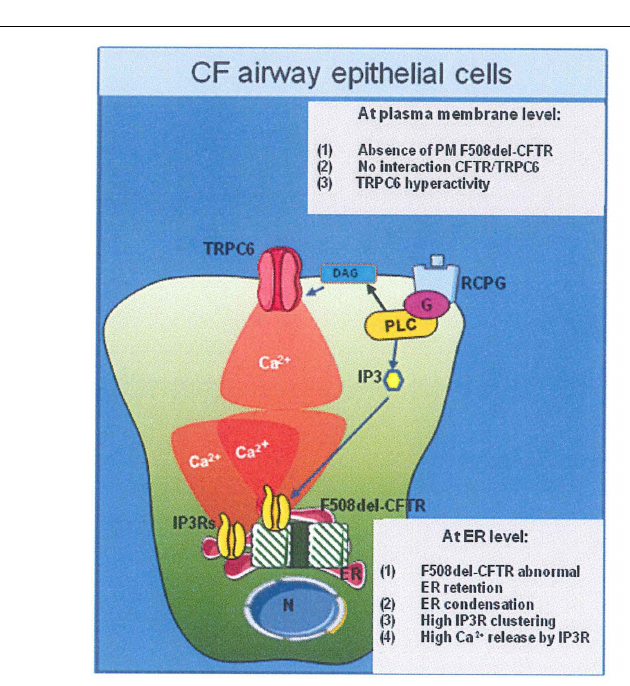
FIGURE 1 | Correlation between ER morphology, IP3R clustering, and IP3R Ca 2 + release plasma. (A) In Non-CF cells, the ER was expended at the totality of cell surface, IP3Rs are distant between others and the IP3R ER Ca 2 + release was normal (B) In CF cells, the F508del-CFTR was trapped into